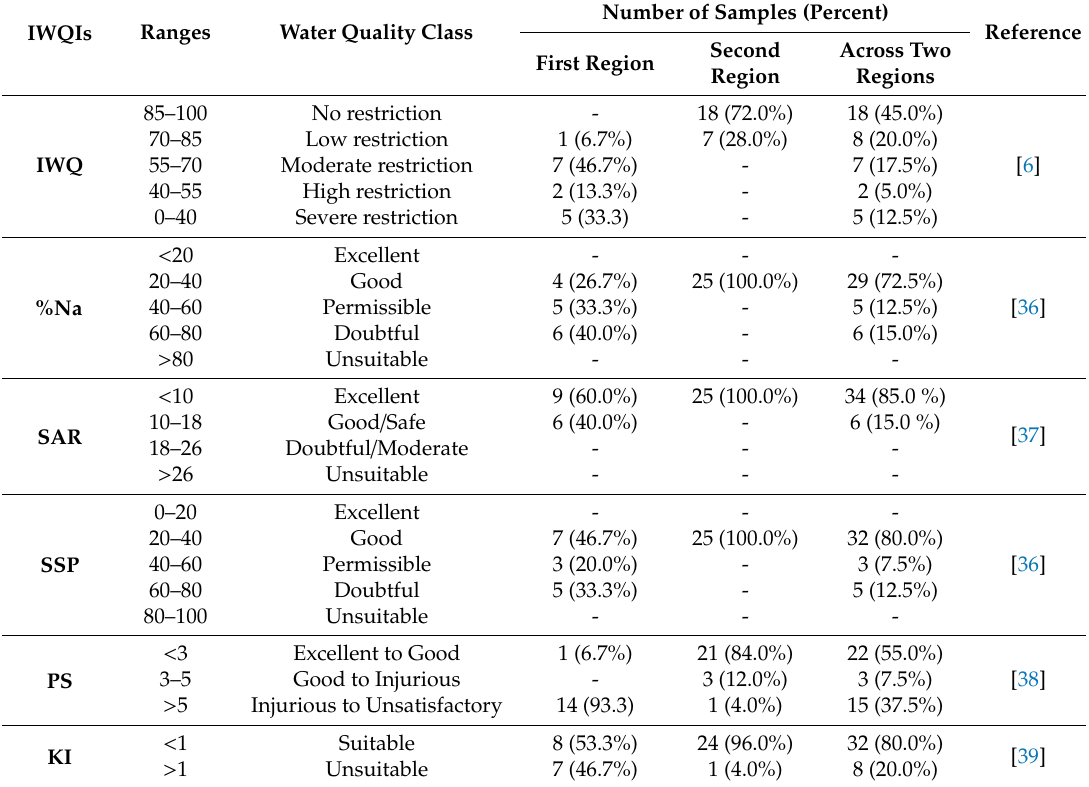
Table 5. Classification of groundwater quality based on di ff erent irrigation water quality indicators (IWQIs): irrigation water quality (IWQ), percent sodium (%Na), sodium absorption ratio (SAR), soluble sodium percentage (SSP), potential salinity (PS), and Kelly’s index (KI) in the Western Desert (WD), Central Nile Delta (CND), and across two